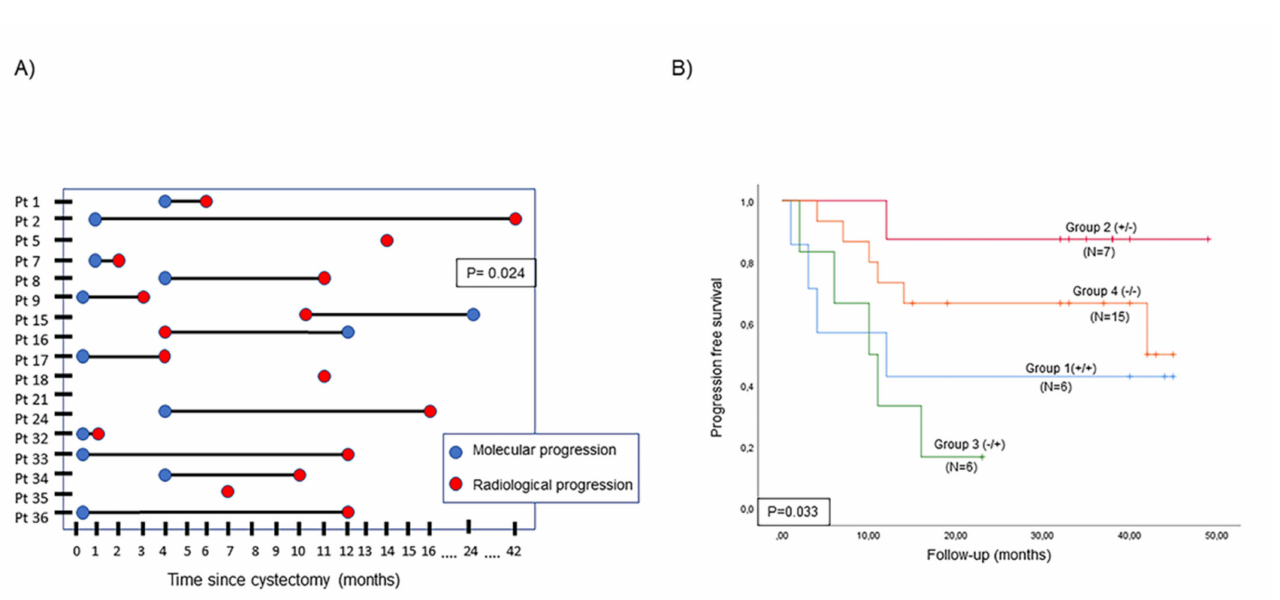
Figure 4. ctDNA status analysis. ( A ) Time of progression according to changes in ctDNA status (molecular progression) and imaging techniques (radiological progression); and ( B ) Kaplan–Meier curve for tumor progression in four different MIBC groups stratified by changes in ctDNA status between baseline and four months after RC (Group 1: patients with positive ctDNA status at both time points; Group 2: patients with positive ctDNA status at baseline and negative ctDNA status four months after RC; Group 3: patients with negative ctDNA status at baseline but positive ctDNA status after RC; Group 4: patients with negative ctDNA status at baseline and later). Abbreviations: Pt;